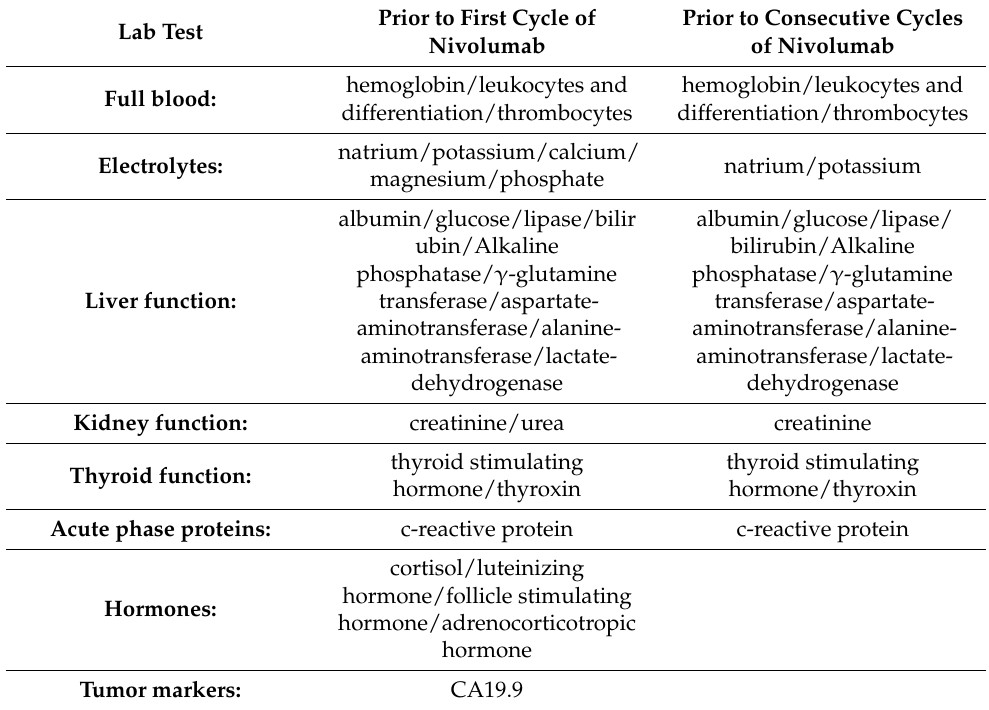
Table 2. Required blood tests prior to Nivolumab administration